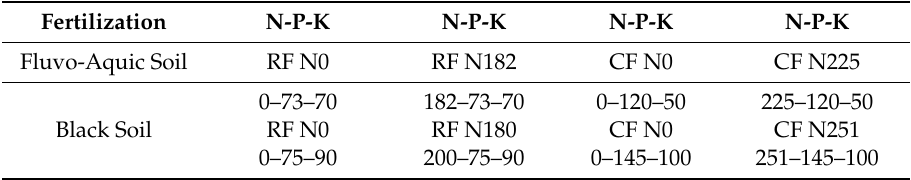
Table 1. Detailed illustration of fertilizer application for maize